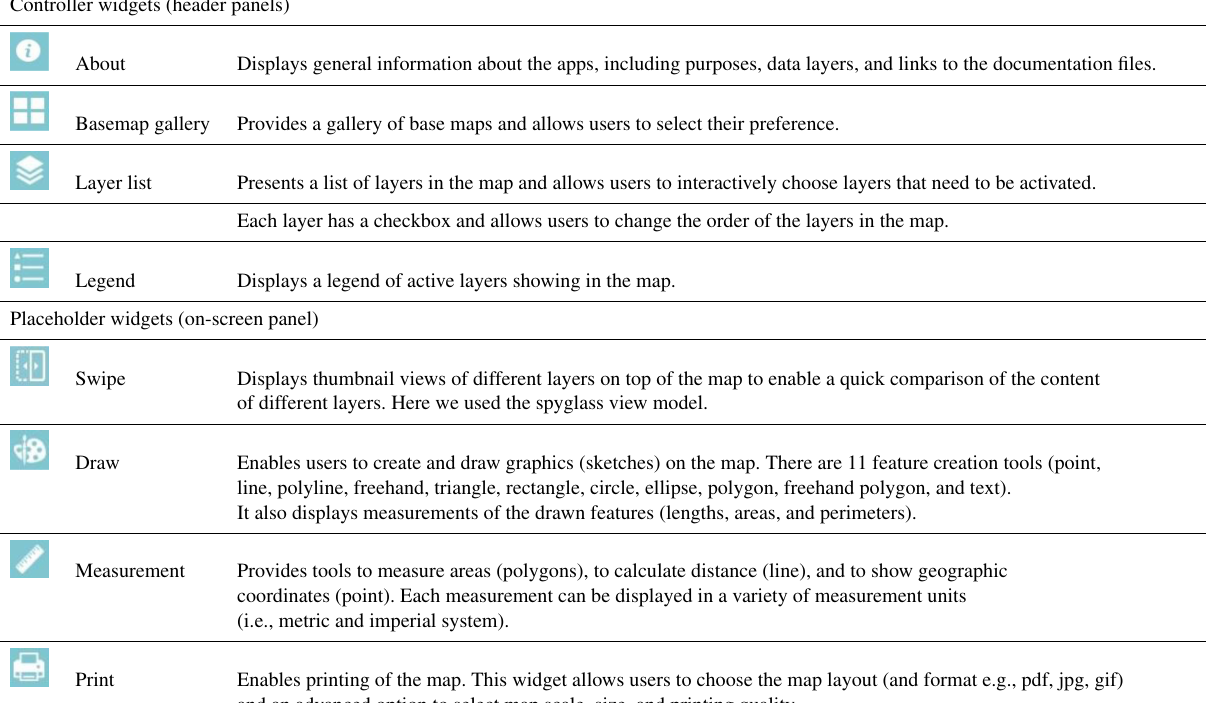
Table 2. Widgets provided for the Coral Triangle Atlas. Icon Widget Functions Controller widgets (header panels) About